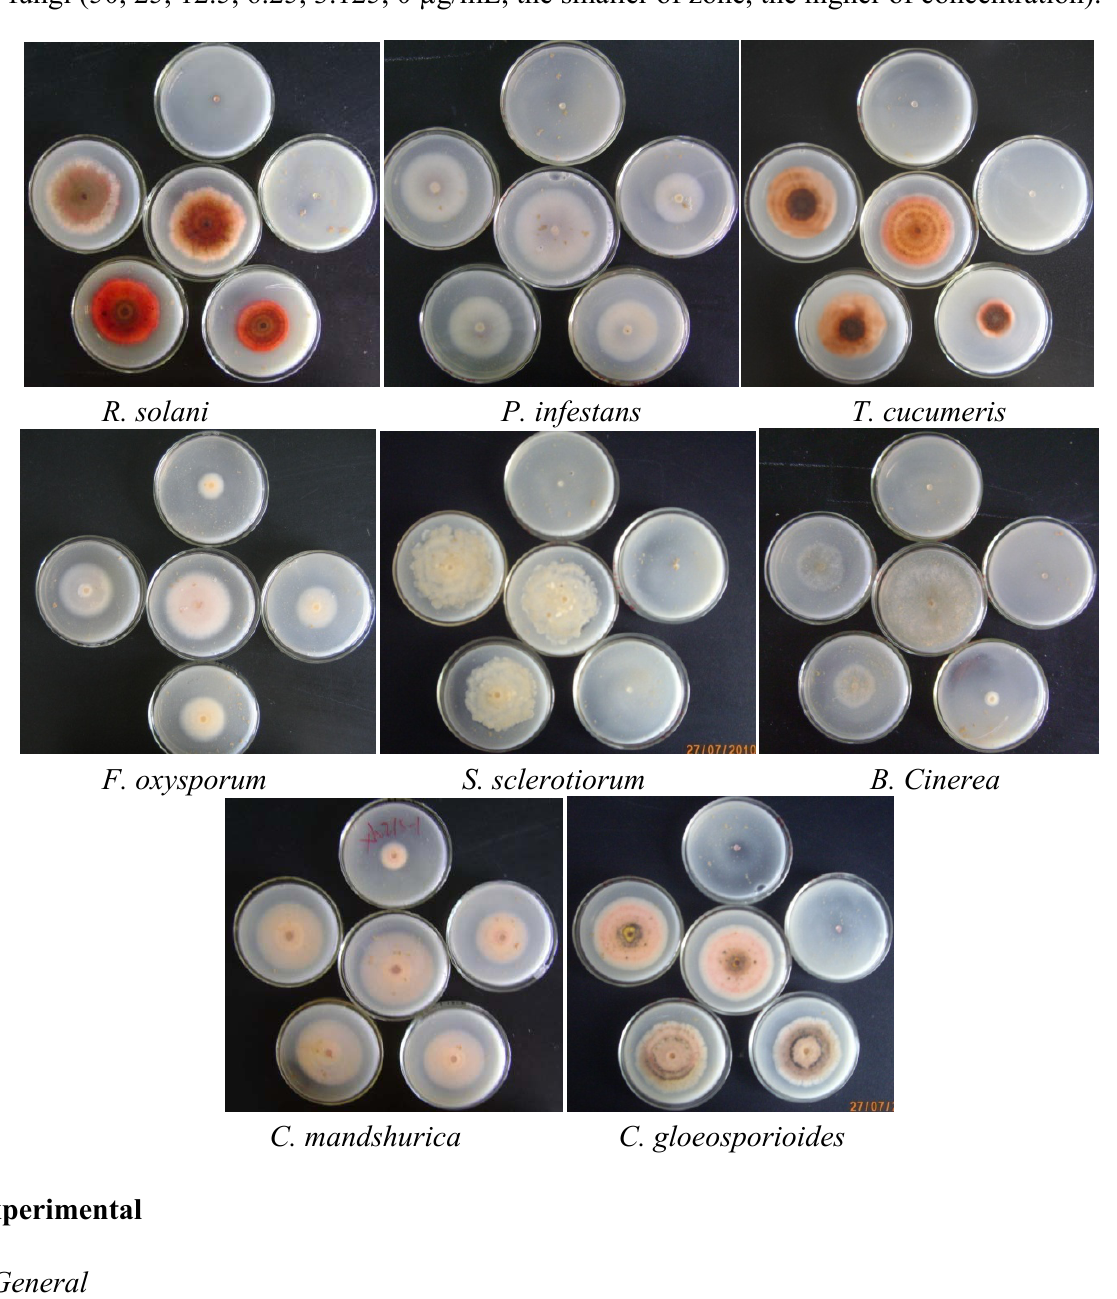
Figure 1. Effect of different concentrations of 5d on the mycelial growth of pathogenic fungi (50, 25, 12.5, 6.25, 3.125, 0 µg/mL, the smaller of zone, the higher of